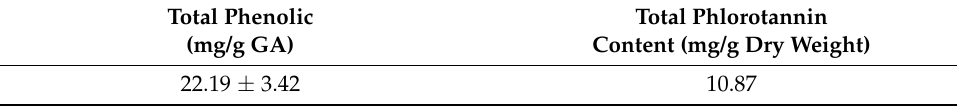
Table 2. Total phenolic and phlorotannin content of S. linifolium brown alga. Total Phenolic GA: gallic acid.